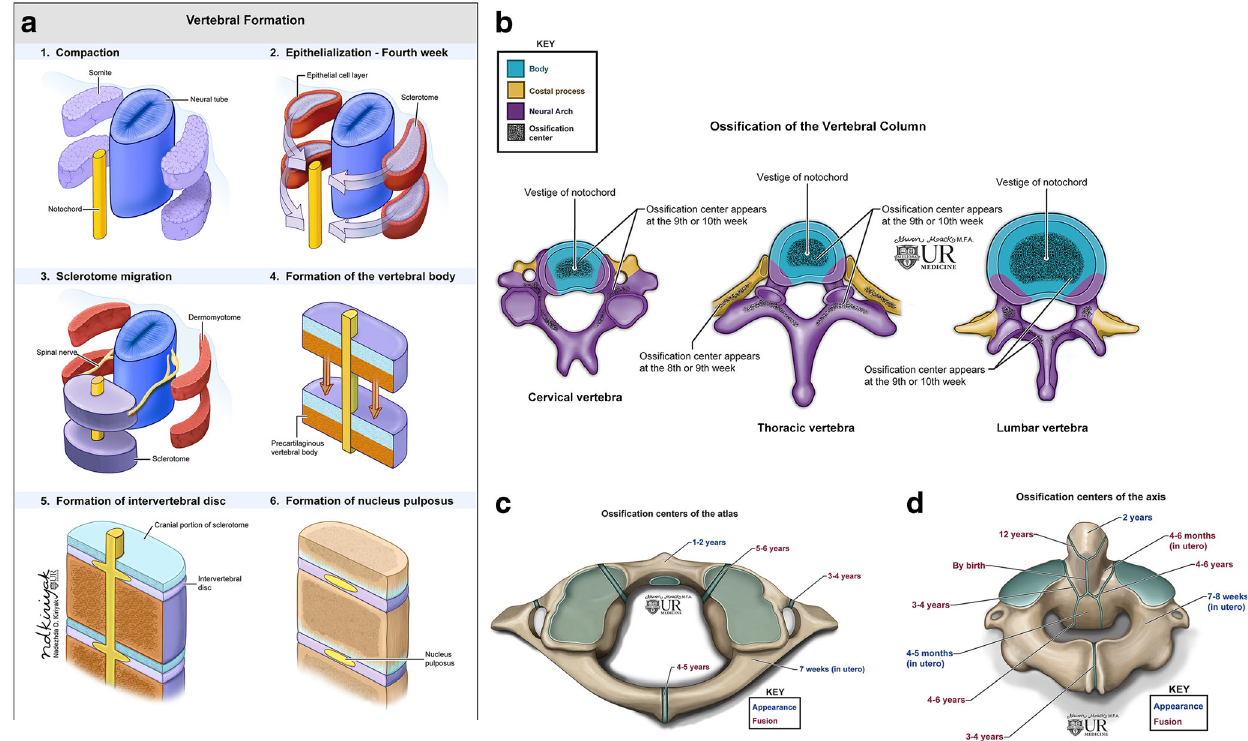
Fig. 1 a - d : Embryology of vertebral bodies and intervertebral discs: Illustration (1 – 6) demonstrating the steps in development of vertebral bodies from sclerotomes. The sclerotomes migrate around the neural tube and the notochord forming the vertebral bodies, arches, transverse and spinous processes. Chondrification centres appear during the 6th week of development within a mesenchymal template, which enclose the notochord and developing neural tube. The notochord expands and develops into the nucleus pulposus of intervertebral disks. The six stages of vertebral development include: (1) gastrulation and formation of the somitic mesoderm and notochord, (2) condensation of the somitic meso- derm into somites, (3) formation of dermomyotomes and sclerotomes, (4) formation of membranous somites and re-segmentation with definitive vertebral formation, (5) vertebral chondrification and (6) vertebral ossification. b : Ossification of subaxial cervical, thoracic and lumbar